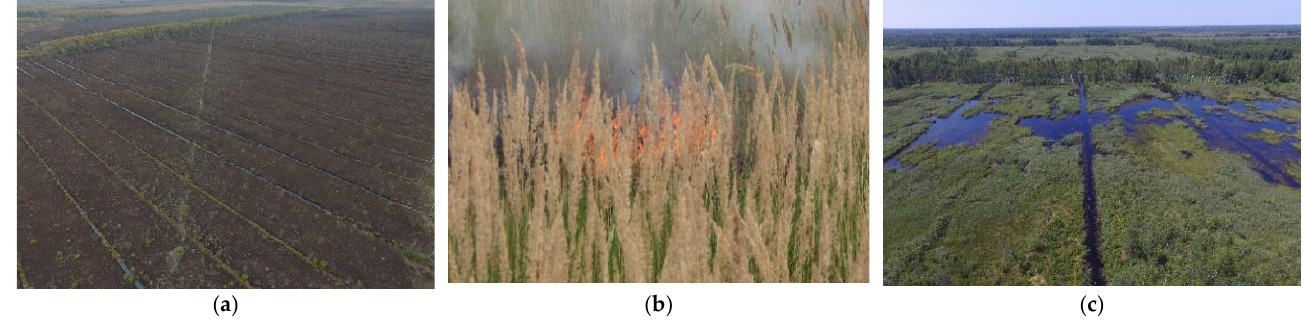
Figure 1. The main impacts (milling peat extraction, fires and rewetting), the impact of which is studied on the example of peatlands in the National Park “Meshchera”, Vladimir region, the center of the European part of Russia. ( a ) Abandoned milled peat extraction. Ostrovsky peatland. Photo by V. Zheltukhin. ( b ) Grass wildfire. Tasinsky peatland. Photo by A. Vozbranaya. ( c ) Rewetting of abandoned milled peat extraction fields. Orlovsky peatland. Photo by V. L’vov .